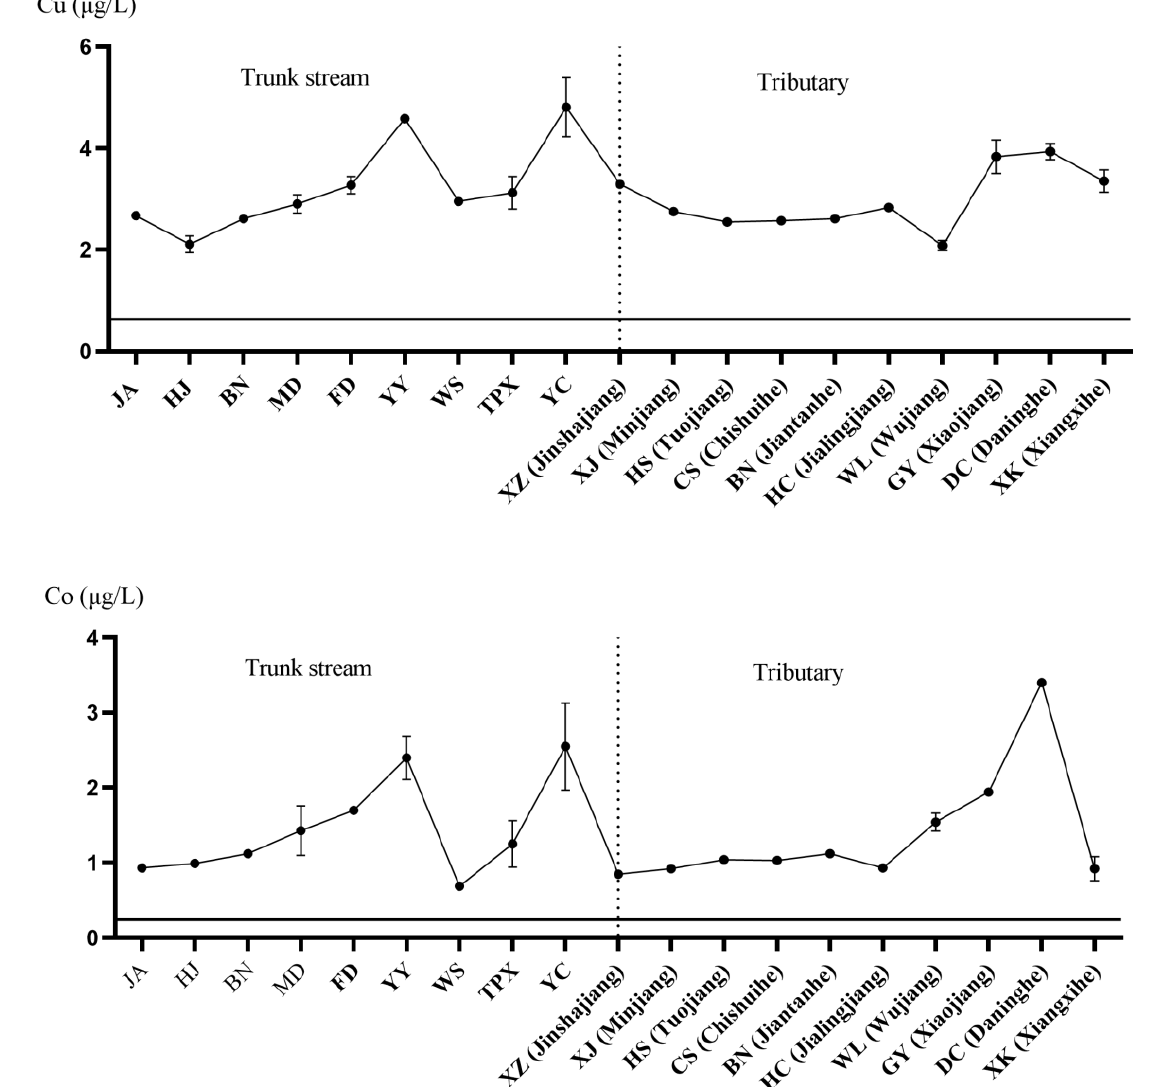
Figure 2. Spatial variance of Cu and Co ( µ g/L) concentrations in the sampling stations of the Yangtze River. The horizontal and solid lines in the figure represent the background values in historical documents. The x -axis is the sampling point. The left side of the vertical dotted line is the main stream and the right side is the tributaries of the Yangtze River. The y -axis is the element concentration.